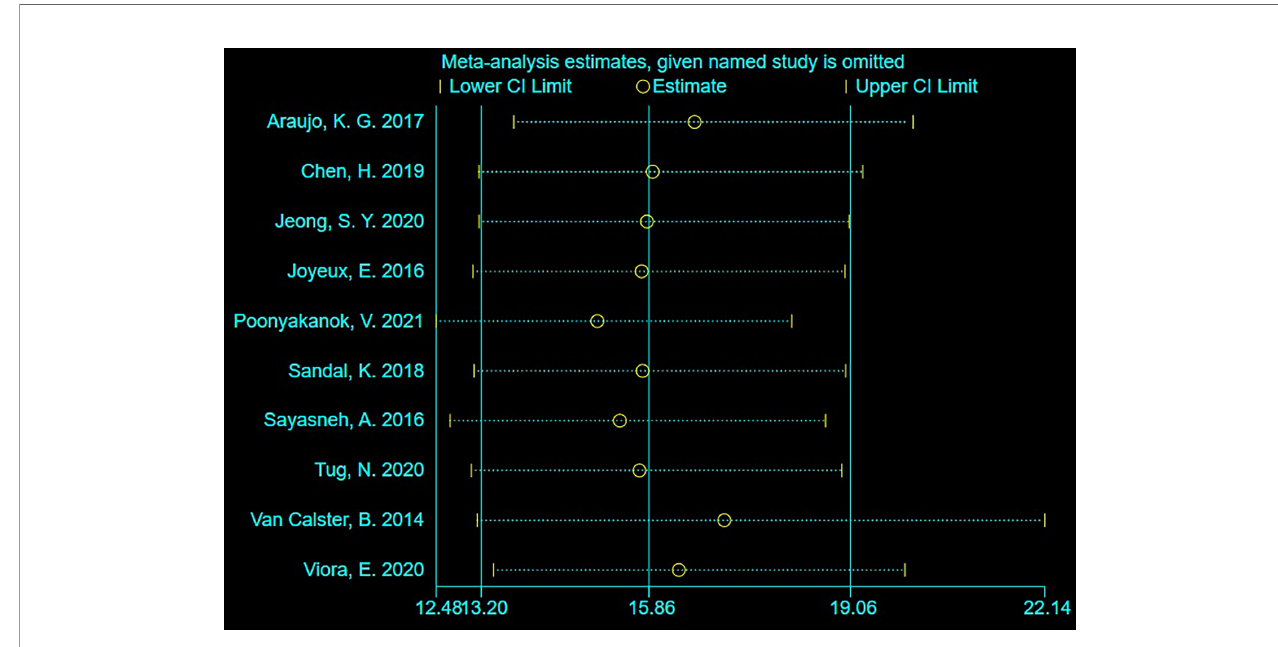
FIGURE 4 | Sensitivity analysis.